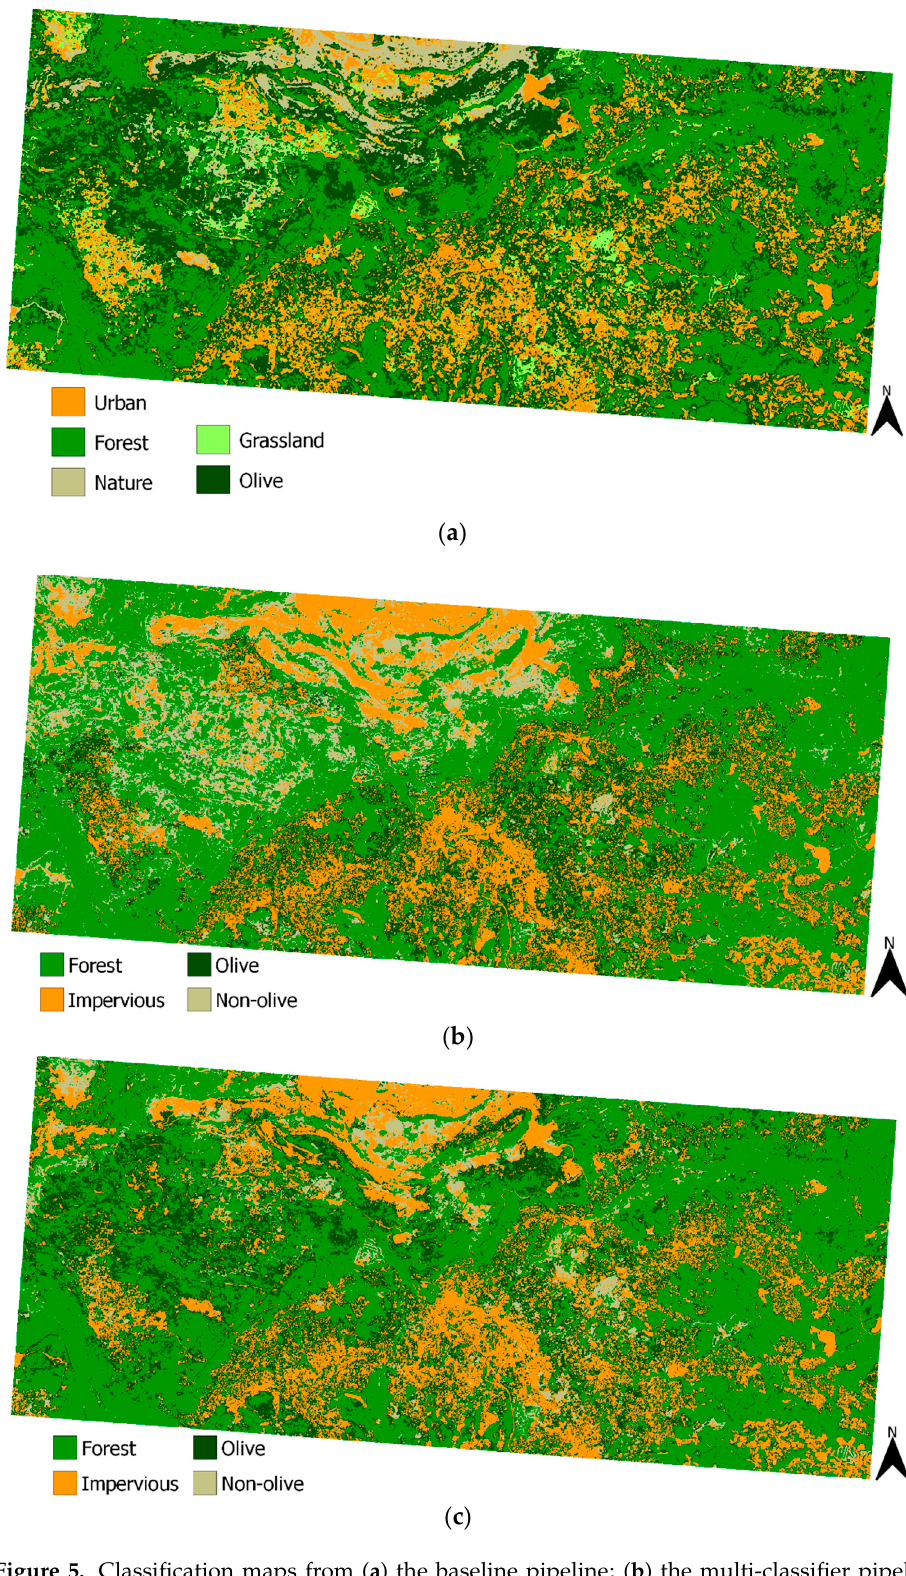
Figure 5. Classification maps from ( a ) the baseline pipeline; ( b ) the multi-classifier pipeline using Multi-Layer Perceptron (MLP); ( c ) the multi-classifier pipeline using One-class Support Vector Machine (OCSVM).